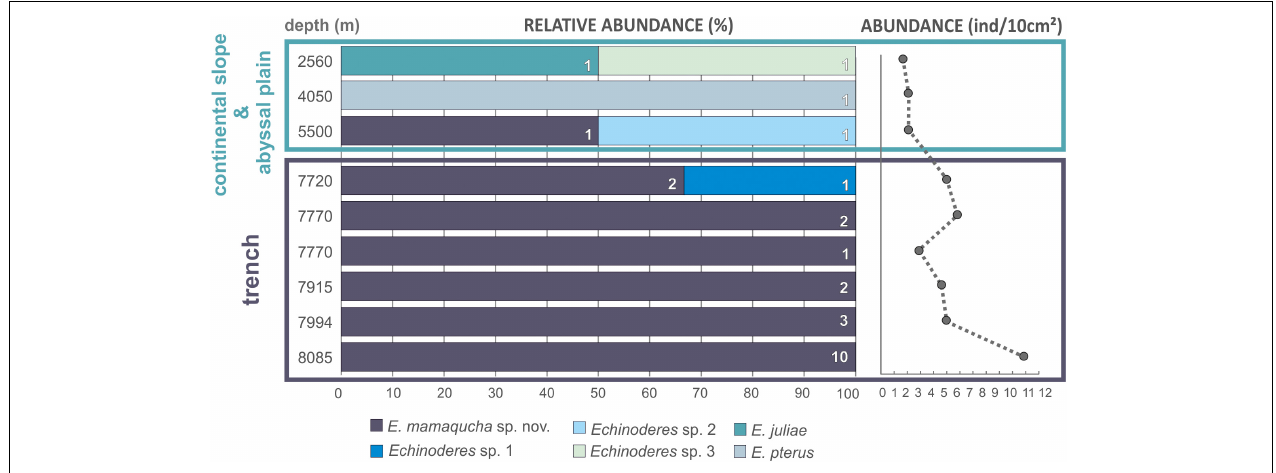
FIGURE 10 | Bathymetric distribution of Echinodere s spp. (left side of the plot) and total abundance of kinorhynchs (right side of the plot) collected along the Atacama Trench hadal zone, adjacent abyssal plain and continental slope.